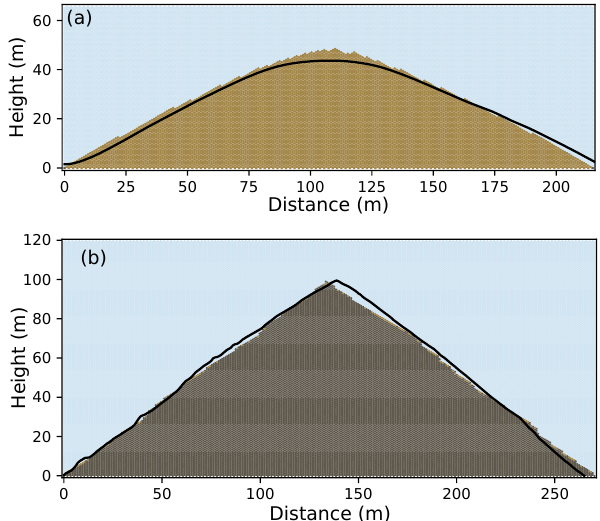
Figure 19. Steady state models using parameters estimated from observed hillslope profiles. (a) Parameters are based on Gabilan Mesa, with the profile shown in Fig. 2a, b for comparison. (b) Pa- rameters based on Yucaipa Ridge, with the profile shown in Fig. 2c, d for